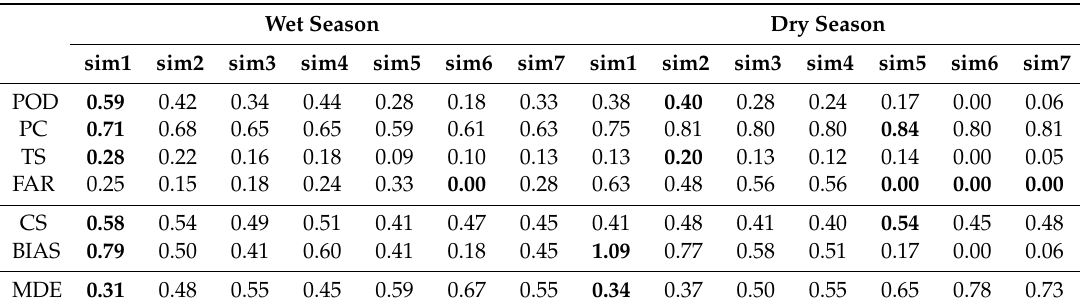
Table 4. Average of the statistical skill scores for the wet and dry seasons for each simulation. CS and MDE stand for combined score and mean absolute distance error, respectively. The thick black bold numbers indicate the highest or unbiased scores for statistical skills for each